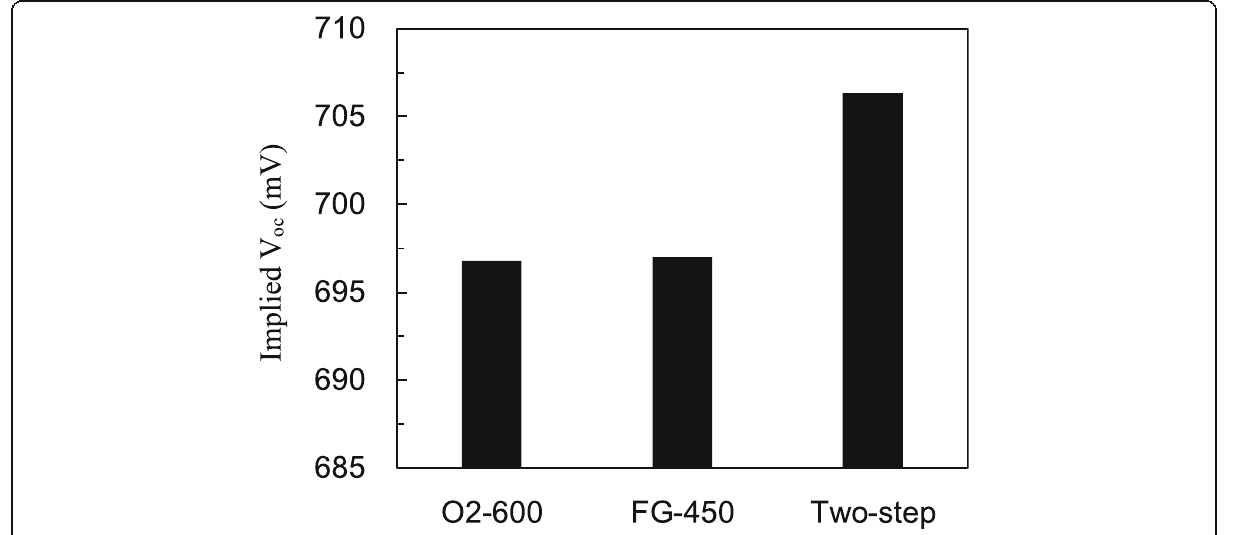
Fig. 6 Implied V oc of the SiN x /Al 2 O 3 -passivated samples with O 2 , FG, and two-step